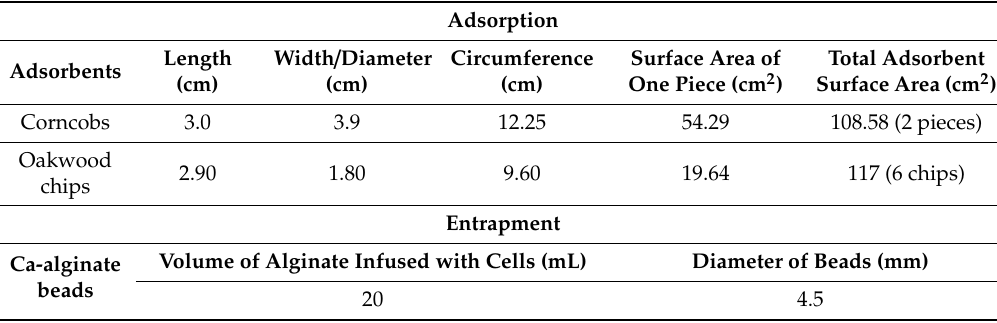
Table 1. Quantity of matrices used per 350 mL of fermentation